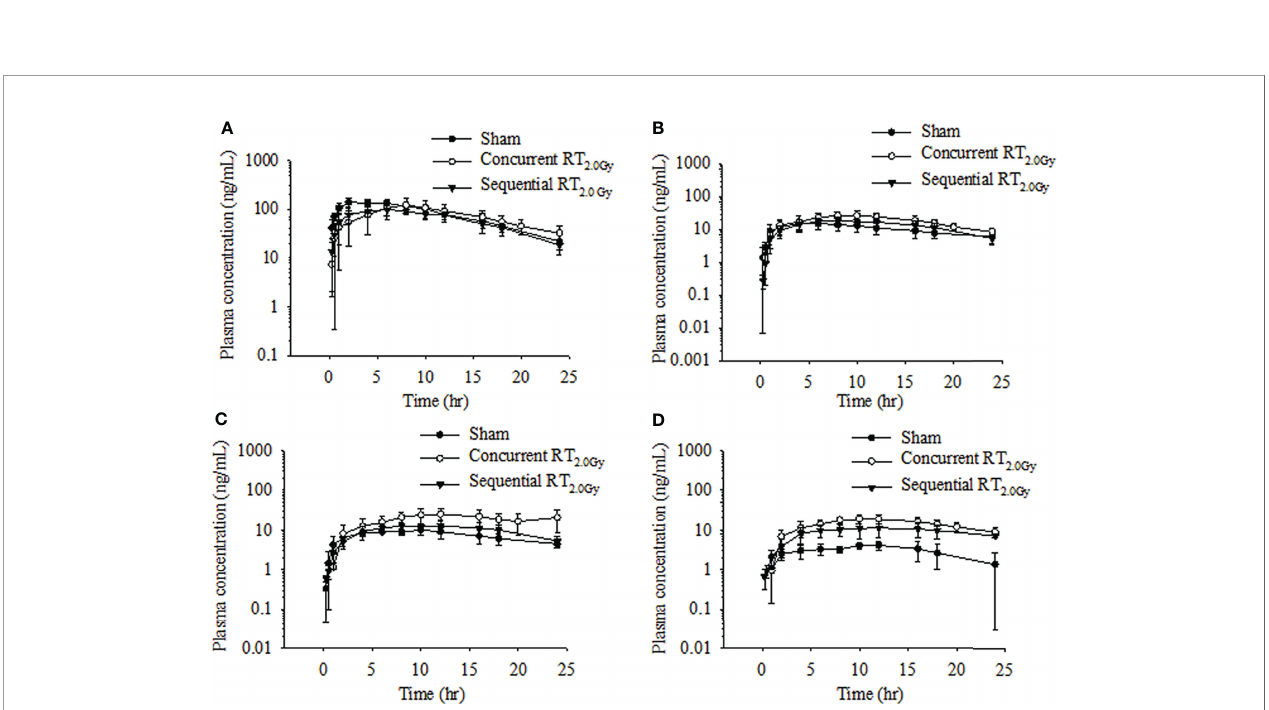
FIGURE 3 | Time – concentration curve of tamoxifen (A) , 4-hydroxytamoxifen (B) , N-desmethyltamoxifen (C) , and endoxifen (D) in rat plasma after oral administration at the dose of RT 0Gy or RT 2.0 Gy . ( ● ) Sham group: tamoxifen administration (10 mg/kg, p.o.) plus RT 0Gy ; ( ○ ) Concurrent RT 2.0Gy group: tamoxifen administration (10 mg/kg, p.o.) plus RT 2.0Gy ; ( ▼ ) Sequential RT 2.0Gy group: tamoxifen administration (10 mg/kg, p.o.) plus RT 2.0Gy . Data are expressed as the mean ± standard deviation ( n = 6 per